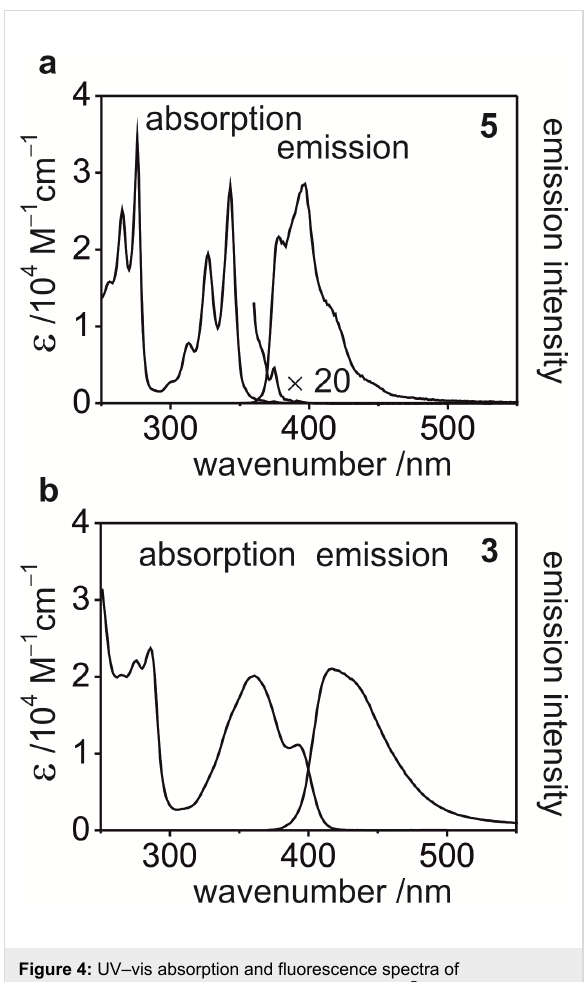
Figure 4: UV–vis absorption and fluorescence spectra of pyrene–adenines 5 (a) and 3 (b) in diluted ( c ≈ 10 − 5 M) dichloro- methane solutions at ambient